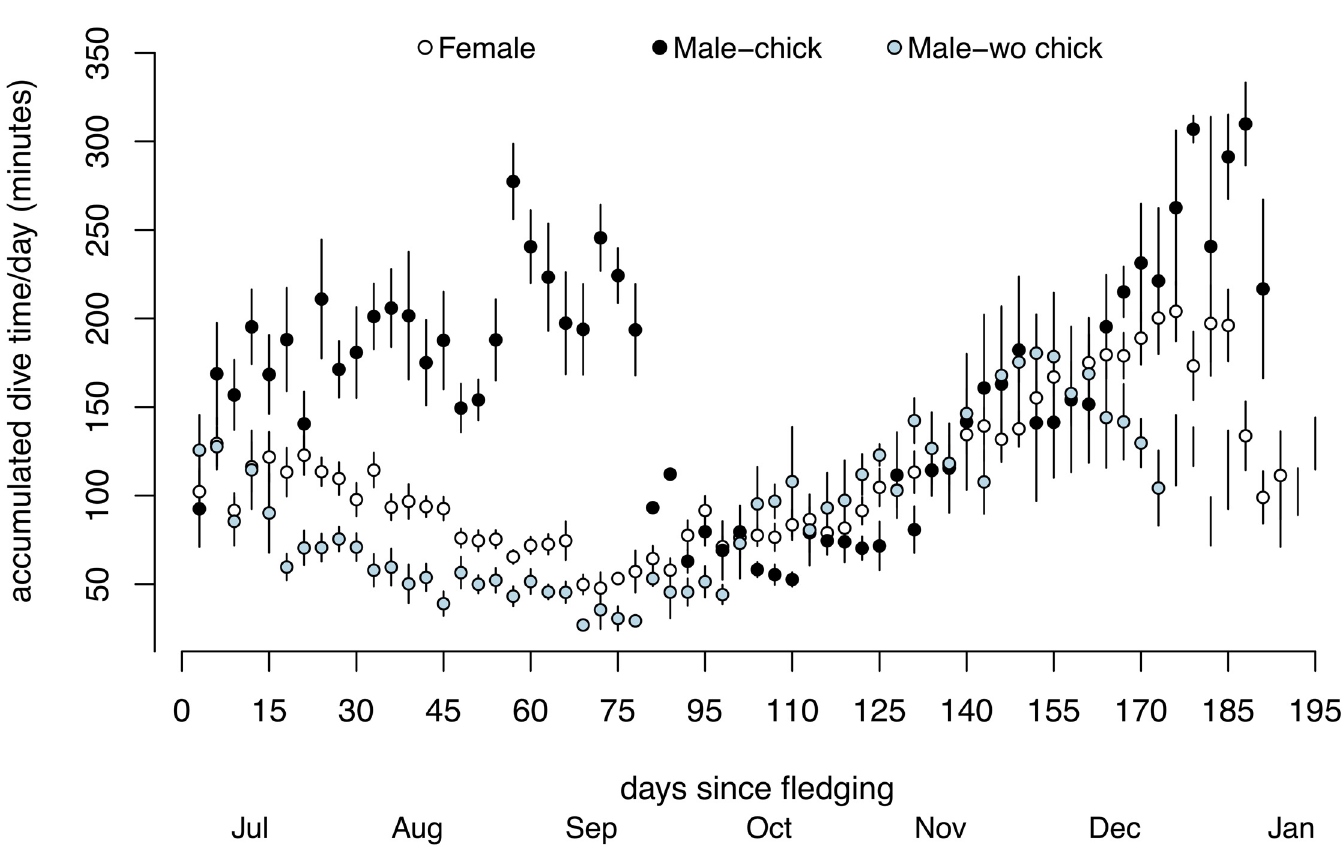
Fig 6. Mean time spent foraging (accumulated dive time; mean ± se) of independent females (n = 11; white circle), single-parenting males (n = 6; black circle) and one unsuccessful male (blue circle) from logger deployment to 31 Jan, showing one data point every third